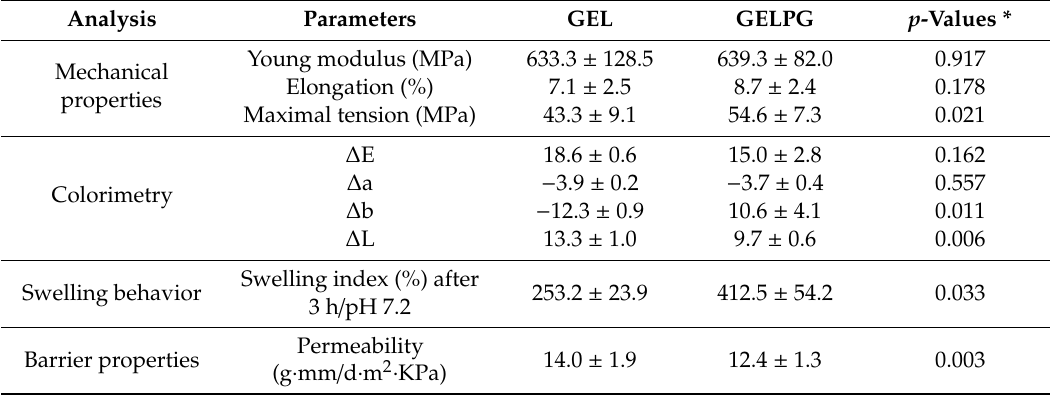
Table 2. Characterization of the